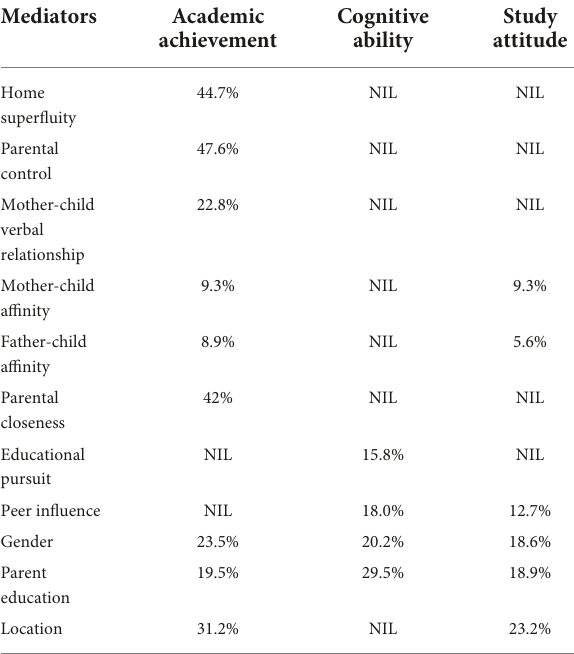
TABLE 6 Proportions of total effect